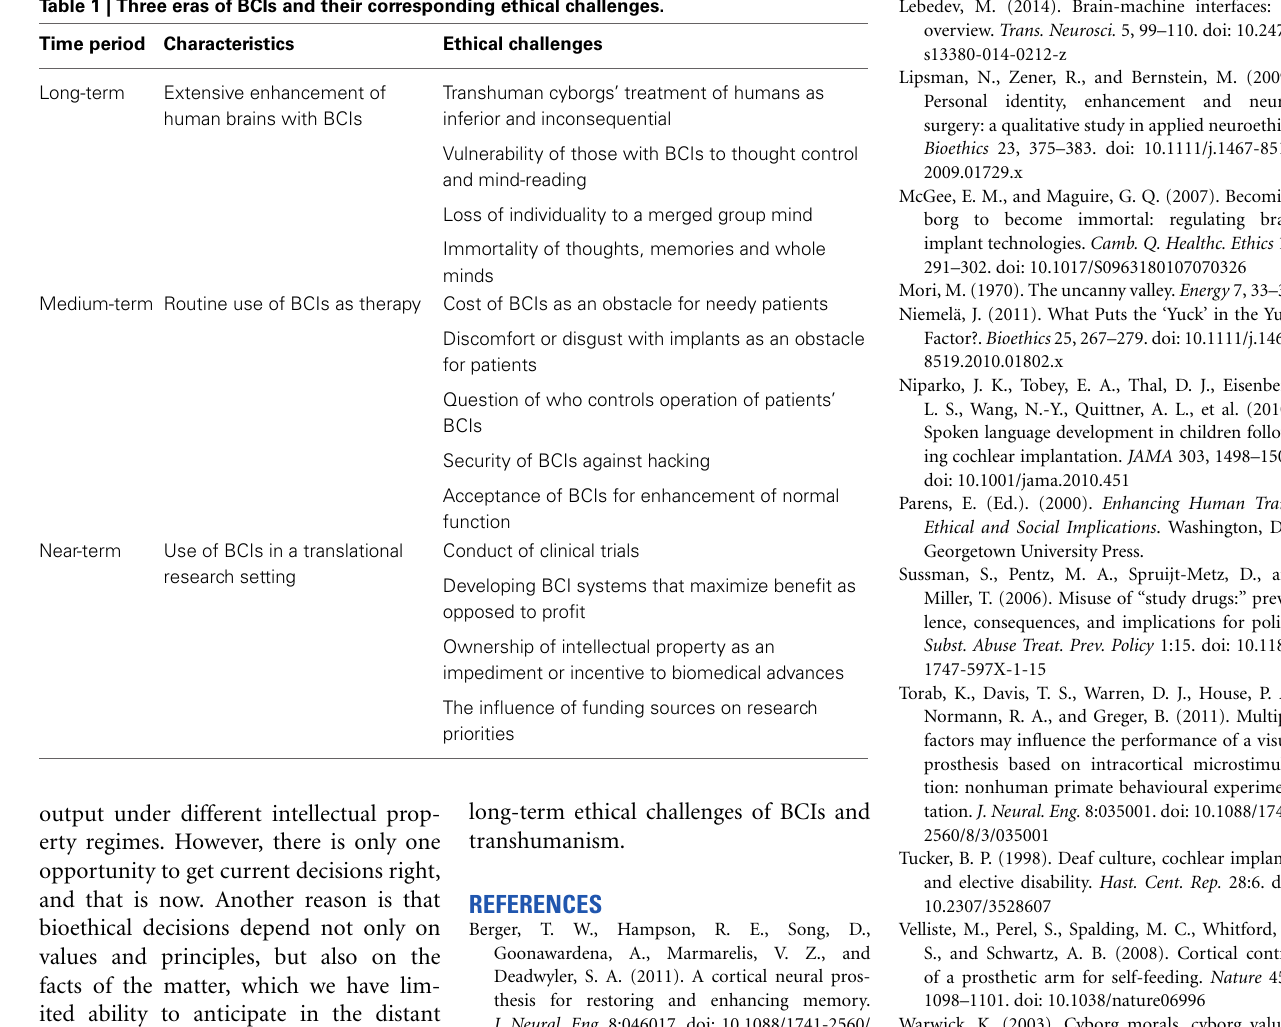
Table 1 | Three eras of BCIs and their corresponding ethical